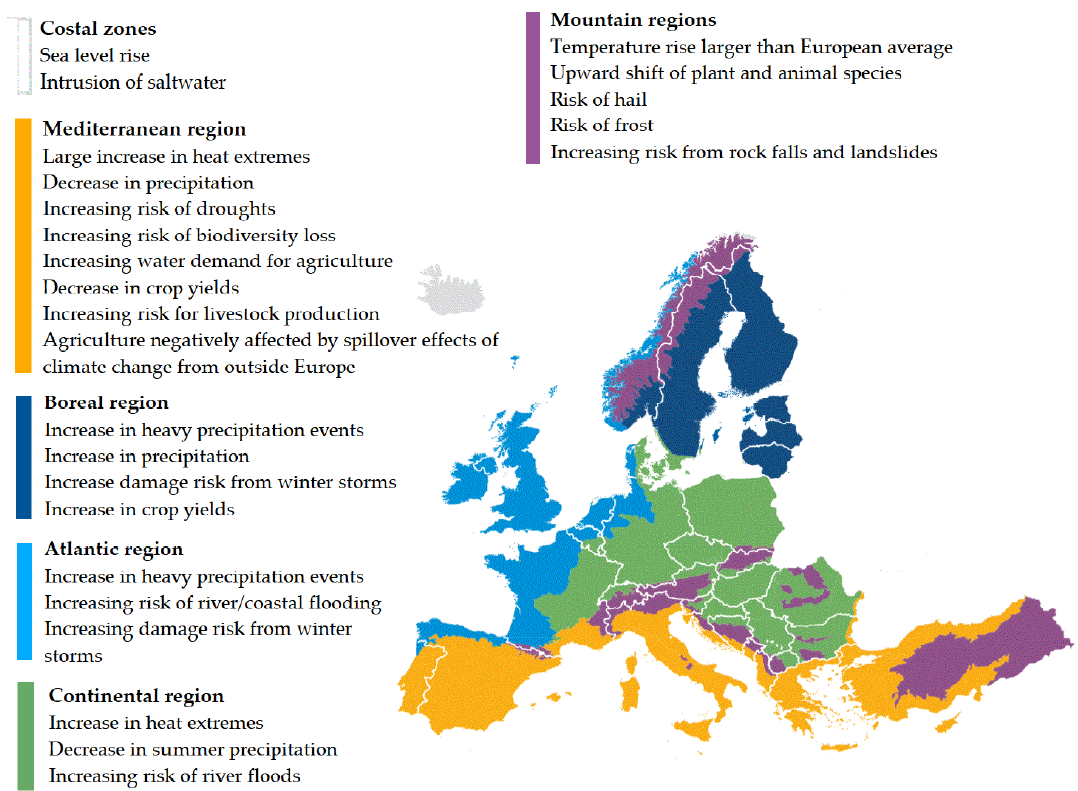
Figure 1. Main biogeographical areas in Europe and projected climate change impacts. Reprinted from European Environment Agency (2017) [29] .